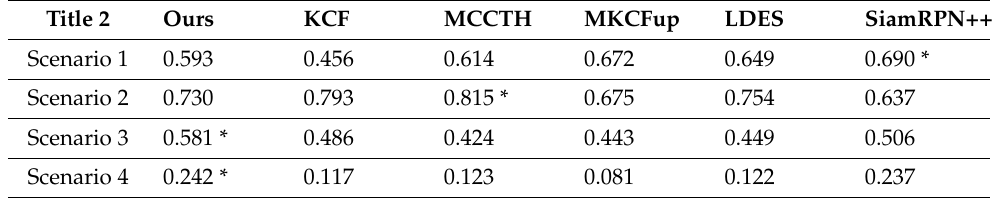
Table 2. Tracking accuracy using